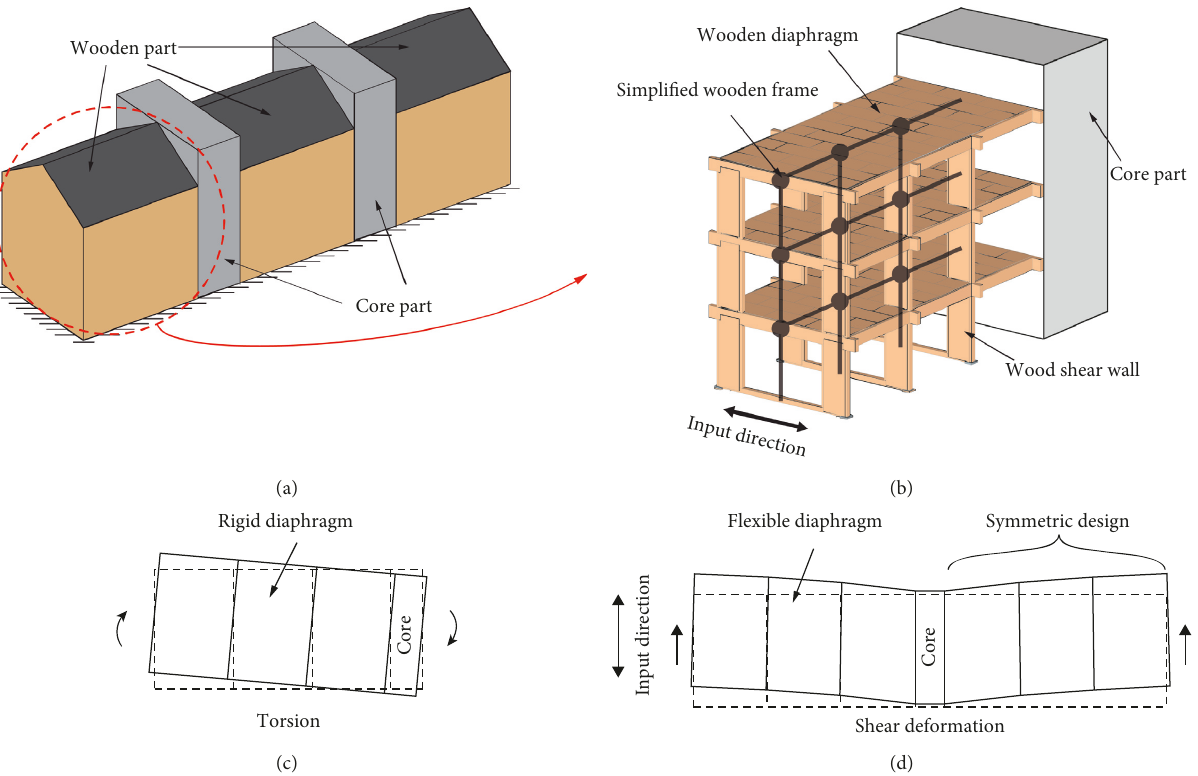
Figure 1: Typical type of wooden horizontal hybrid structure. (a) General layout. (b) One kind of detailed design of the wooden part and the possible simplified frame. Relative deformation mechanism (c) building with rigid diaphragm and (d) building with flexible diaphragm and symmetric